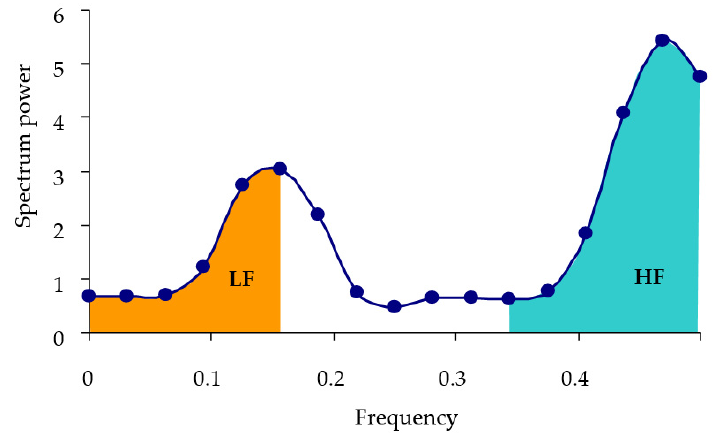
Figure 2. Typical form of the function H ( f ) spectrum. NDVI response to the change in LST . Trial plot no. 10 in the population outbreak focus of Siberian silkmoth, 2010.